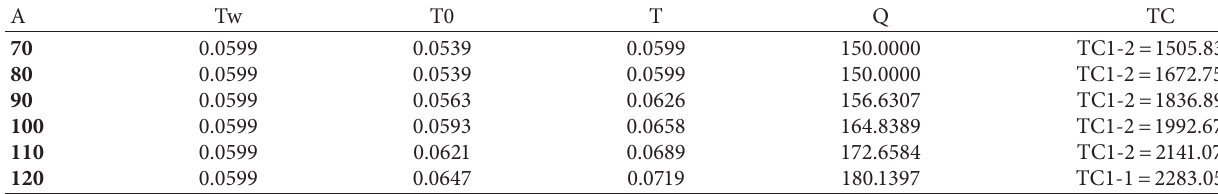
Table 1: The obtained solutions under different values of